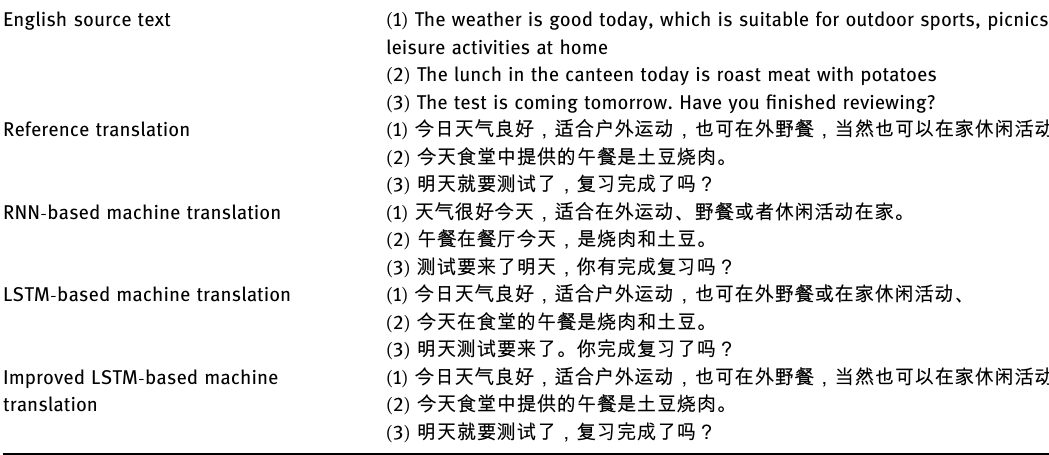
Table 3: Partial translation results of three machine translation algorithms English source text